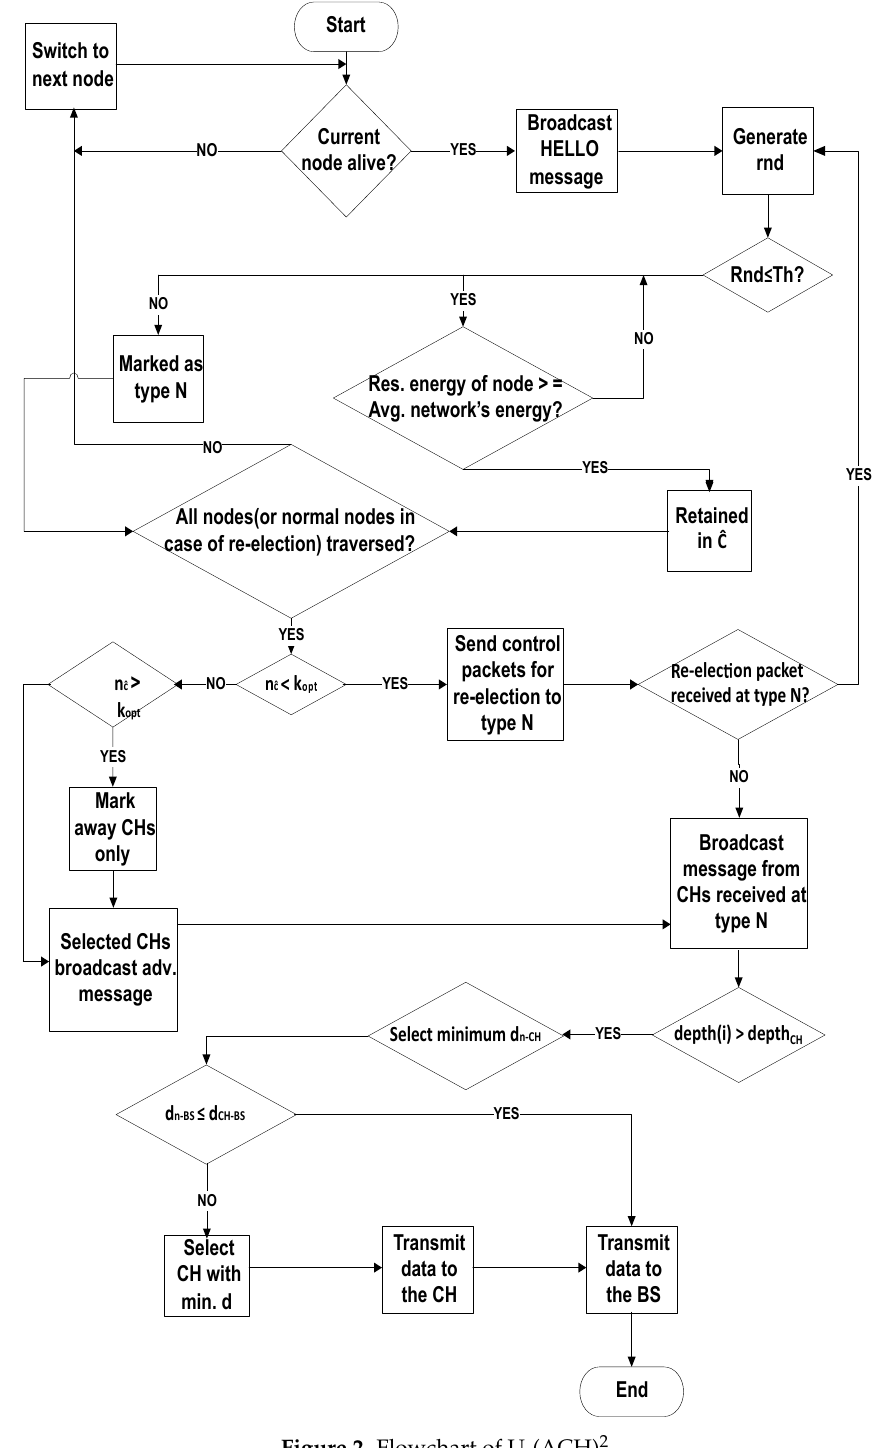
Figure 2. Flowchart of U-(ACH) 2